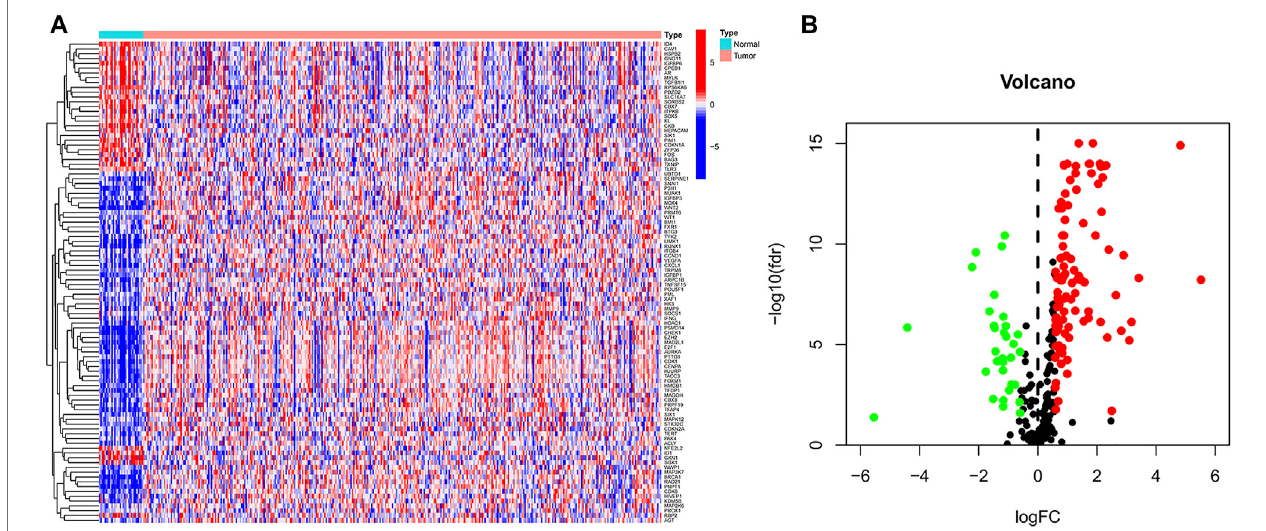
FIGURE 1 | Cellular senescence-related differential genes between tumor samples and normal samples. (A) Heat map. (B) Volcano plot. Green, downregulated; red, upregulated.